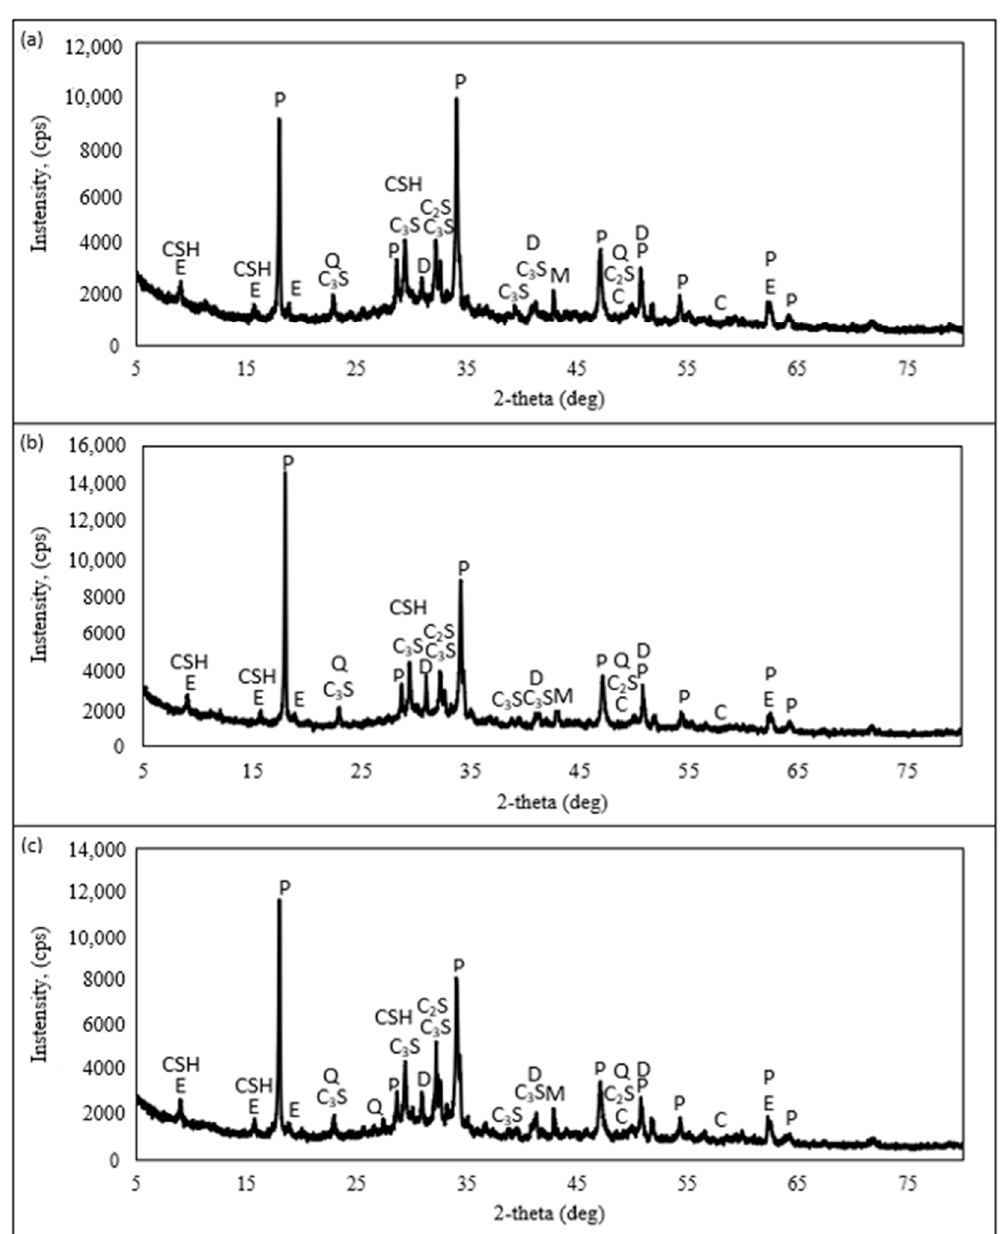
Figure 7. XRD image of hardened cement paste: ( a ) without sludge, ( b ) with 10% cement replaced with dry concrete sludge, ( c ) with 10% cement replaced with wet concrete sludge; C—calcite; P—portlandite; D—dolomite; E—ettringite; C 3 S—tricalcium silicate; C 2 S—dicalcium silicate; CHS—calcium silicate hydrate; Q—quartz.